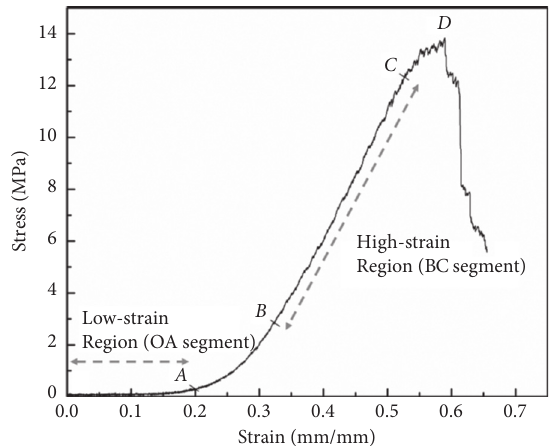
Figure 2: The stress-strain curve of a corneal strip